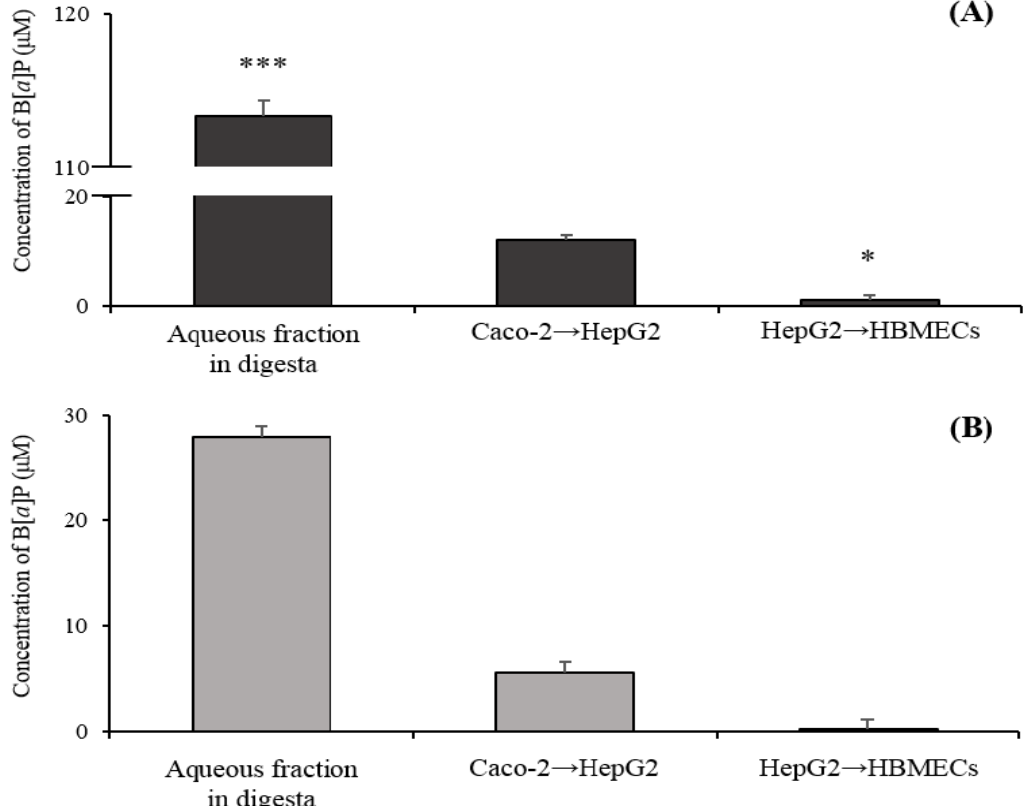
Figure 6. The transported concentration of B[ α ]P to HBMECs by the in vitro bio-mimic system (Upper GI tract → human intestinal epithelial cells (Caco-2) → HepG2 → HBMECs). B[ α ]P only ( A ) and B[ α ]P with catechins ( B ). The values are mean ± SD in triplicate. The asterisk indicates a significant difference between groups. (* p < 0.05 and *** p < 0.001).